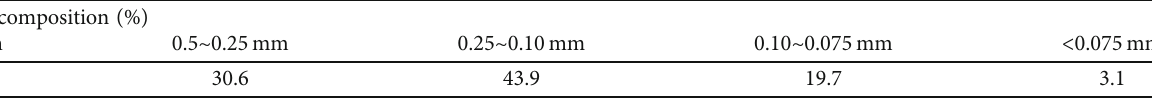
Table 1: Particle composition of fi ne sand used in the experiments.